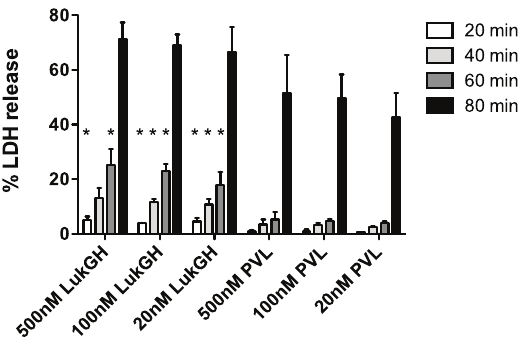
Figure 4. Cytolytic activities of LukGH and PVL in human PMNs. PMNs (1 6 10 6 /mL) were incubated with indicated concentra- tions of LukGH or PVL for 20–80 min and LDH concentration in the supernatant was measured using the Roche Cytotoxicity Detection Kit. Percent LDH release was calculated according to the formula described in the methods section by using 1% Triton X-100 to estimate maximal LDH release. The results represent the mean of three independent experiments 6 SEM. * indicates statistical significance from PVL at the same concentration and time.